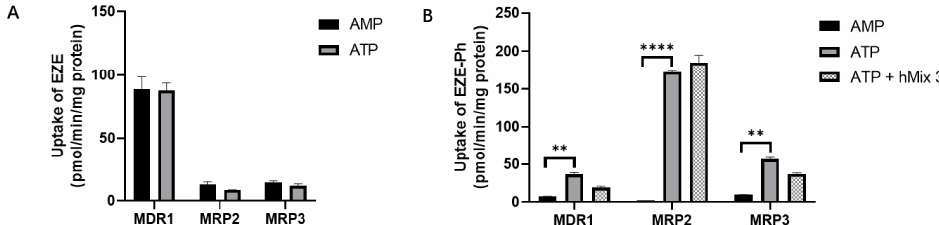
Figure 12. ( A ) Direct transport of 10 µ M EZE via MDR1, MRP2, and MRP3, and ( B ) inhibitory effects of bile acid mixtures on the direct transport of 10 µ M EZE-Ph by MDR1, MRP2, and MRP3. Compounds were incubated for 10 min with transporter-expressing membrane vesicles with or without ATP. Data were expressed as mean ± S.D. ( n = 3). ** p < 0.01 and **** p < 0.0001 compared with control.